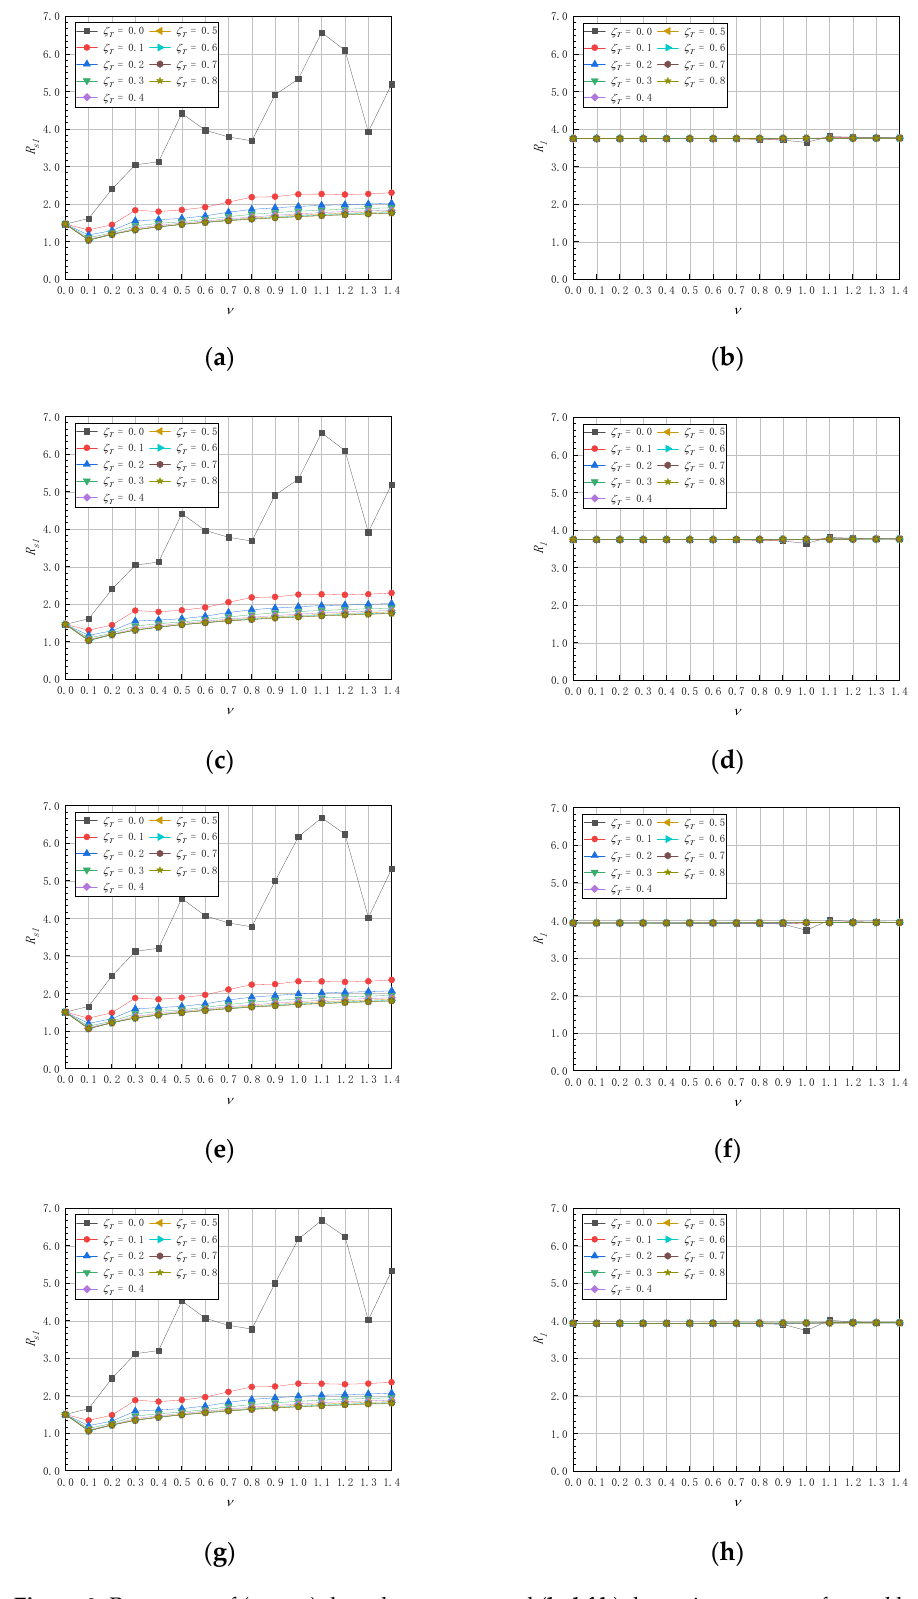
Figure 8. Responses of ( a , c , e , g ) the substructures and ( b , d , f , h ) the main structures formed by 3, 6, 10, and 20 modules.